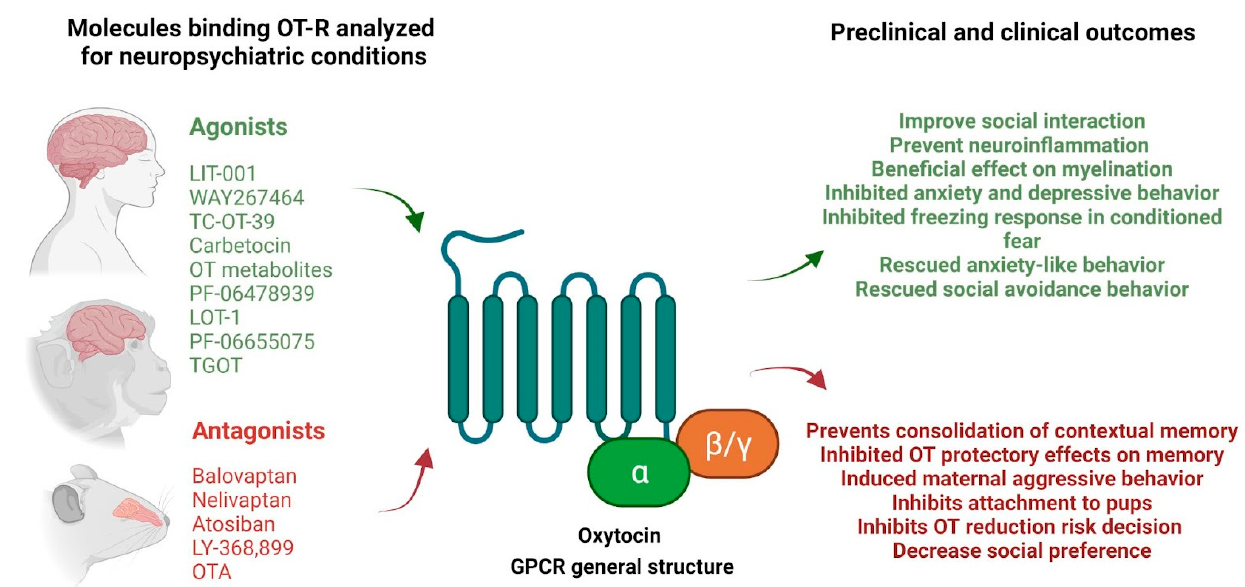
Figure 1. Examples of agonists and antagonists with affinity for OT-R and their principal preclinical and clinical outcomes reported. Scheme created with BioRender.com (October 19, 12:20 GMT-3).